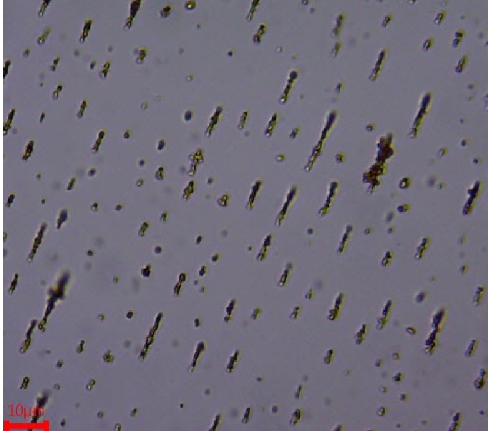
Figure 8. Experimental results for the aggregation of particles for 30 µ L of